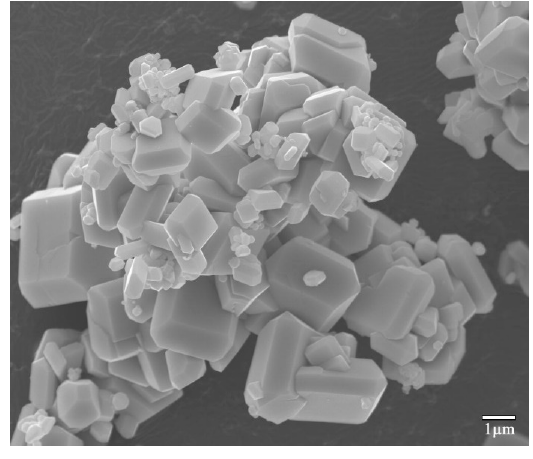
Fig. 8 FE-SEM image of BiVO 4. Figure 8. FE-SEM image of BiVO